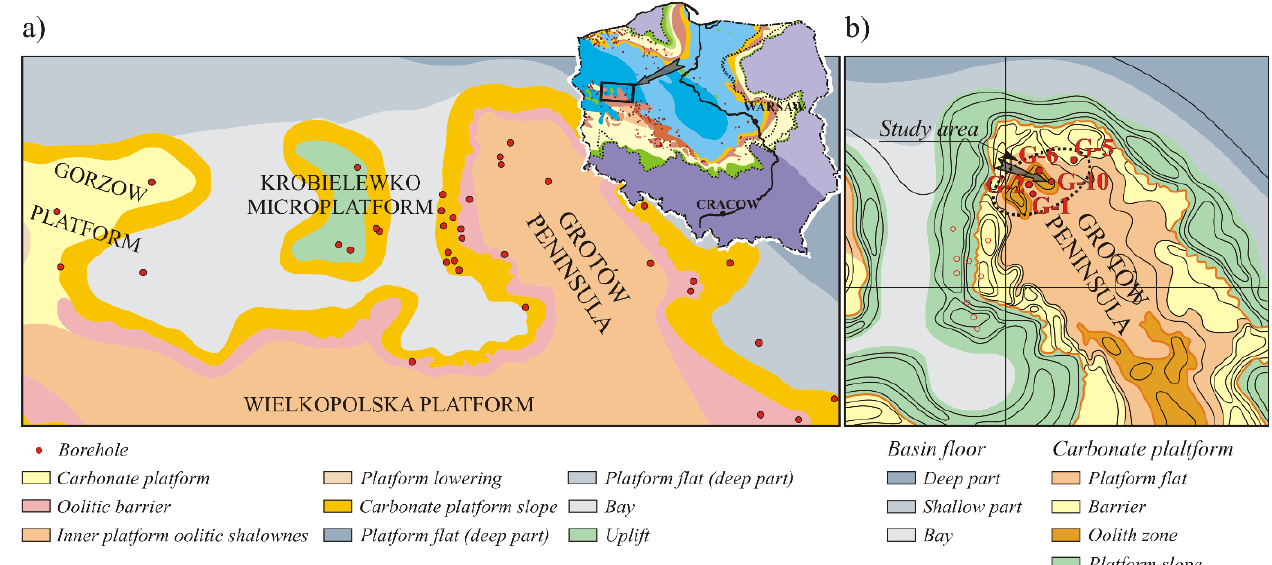
Figure 1. Location of the study area in the background of Polish Lowland ( a ) Gorzów Platform, ( b )Grotów Peninsula(magnified); black arrow in (a) indicates position of the Gorzów Platform;black arrow in (b) indicates G-10 Well position ([14,15], modified).